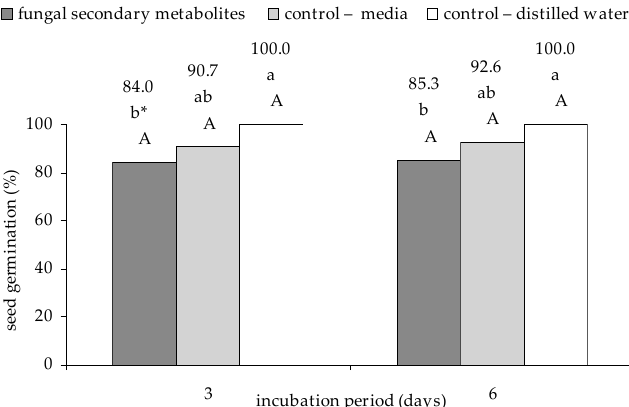
Figure 1. Effect of the culture filtrates from 18 strains of E. nigrum on seed germination of garden cress ( L. sativum L.) after 3 and 6 days of incubation. Means followed by the same letter (*) are not statistically different at the α ≤ 0.01 level, according to the Tukey honest significant difference (HSD) test. Small letters indicate the differences in the percentage of germinated seeds due to filtrate type within a given incubation period. Capital letters indicate the differences in the percentage of germinated seeds due to incubation period within filtrate.